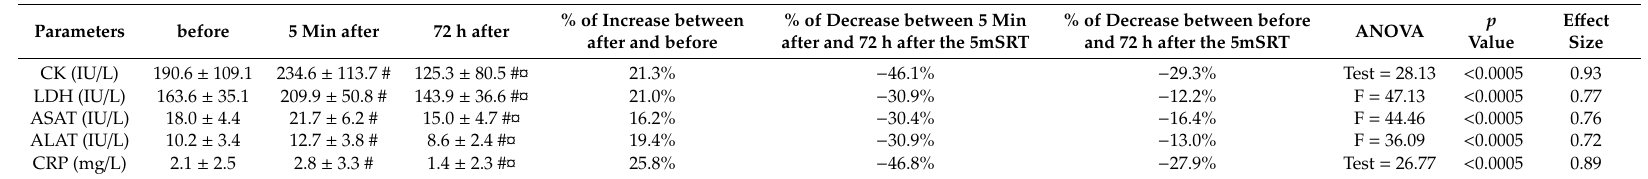
Table 1. Values (mean ± standard deviation) of biochemical parameters before, 5 min and 72 h after the 5mSRT.